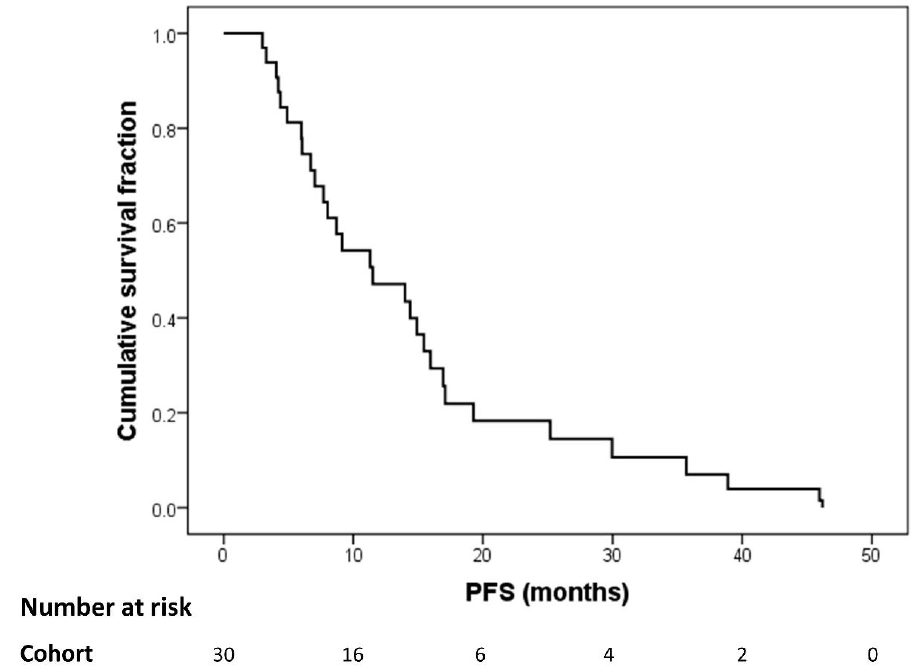
Figure 2. Kaplan–Meier curve for progression-free survival (PFS) with everolimus for the total cohort.